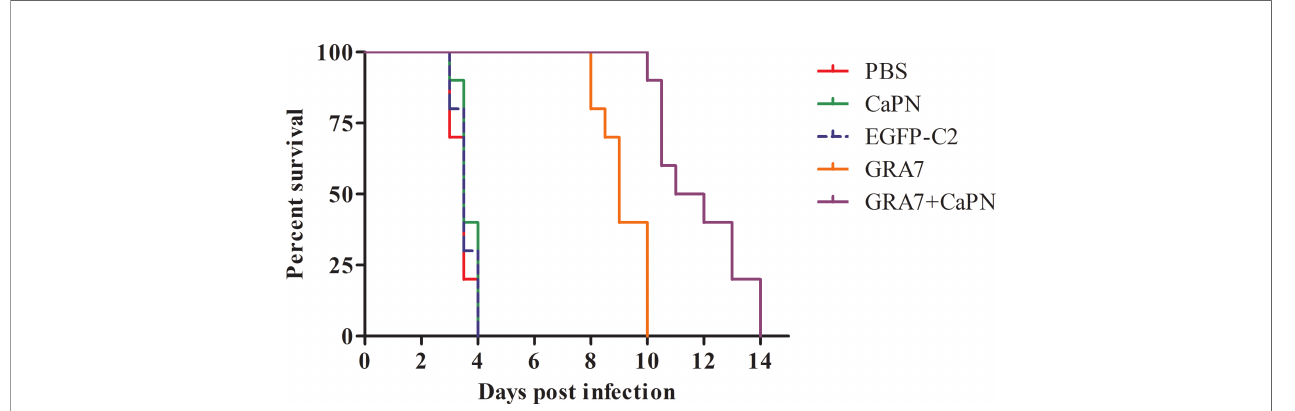
FIGURE 6 | Survival time of BALB/c mice after challenge with Toxoplasma gondii tachyzoites. Each group contained 10 mice, and survival was signi fi cantly higher in the GRA7-pEGFP-C2+nano-adjuvant (CaPNs) – immunized mice than that in control mice.